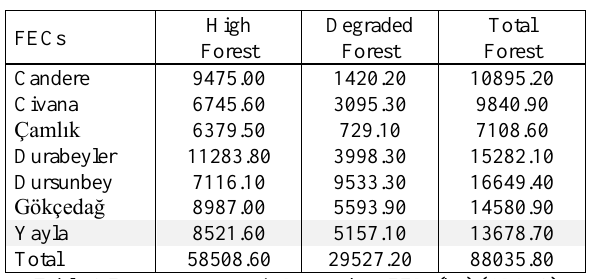
Figure 1. The study area map